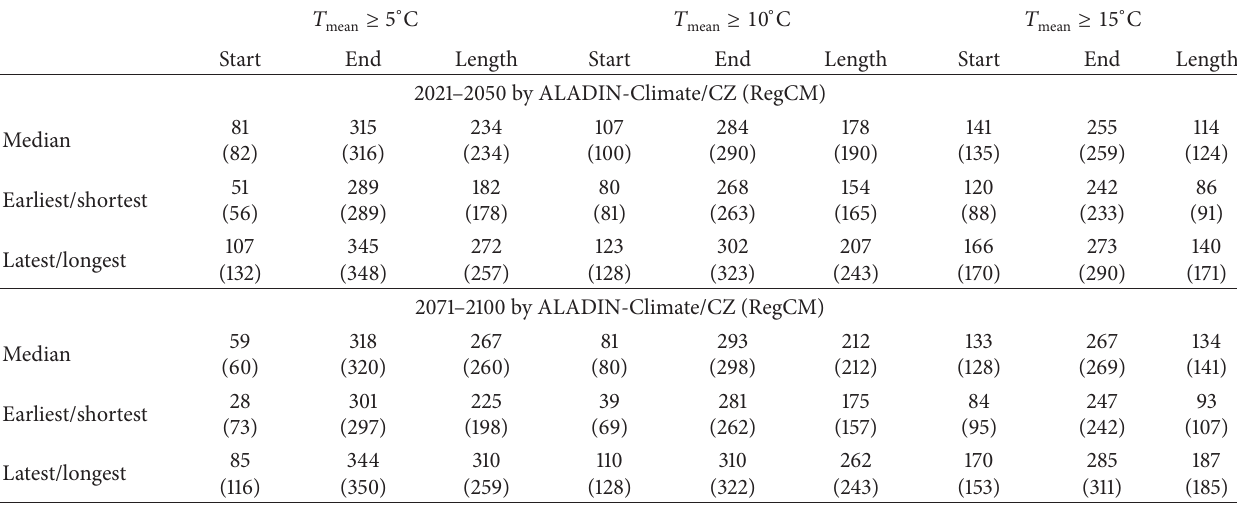
Table 4: Projected dates of the start, end, and length of the regional growing season for two future periods (2021–2050 and 2071–2100) based on two different RCMs by A1B scenario run over the Elbe River lowland.